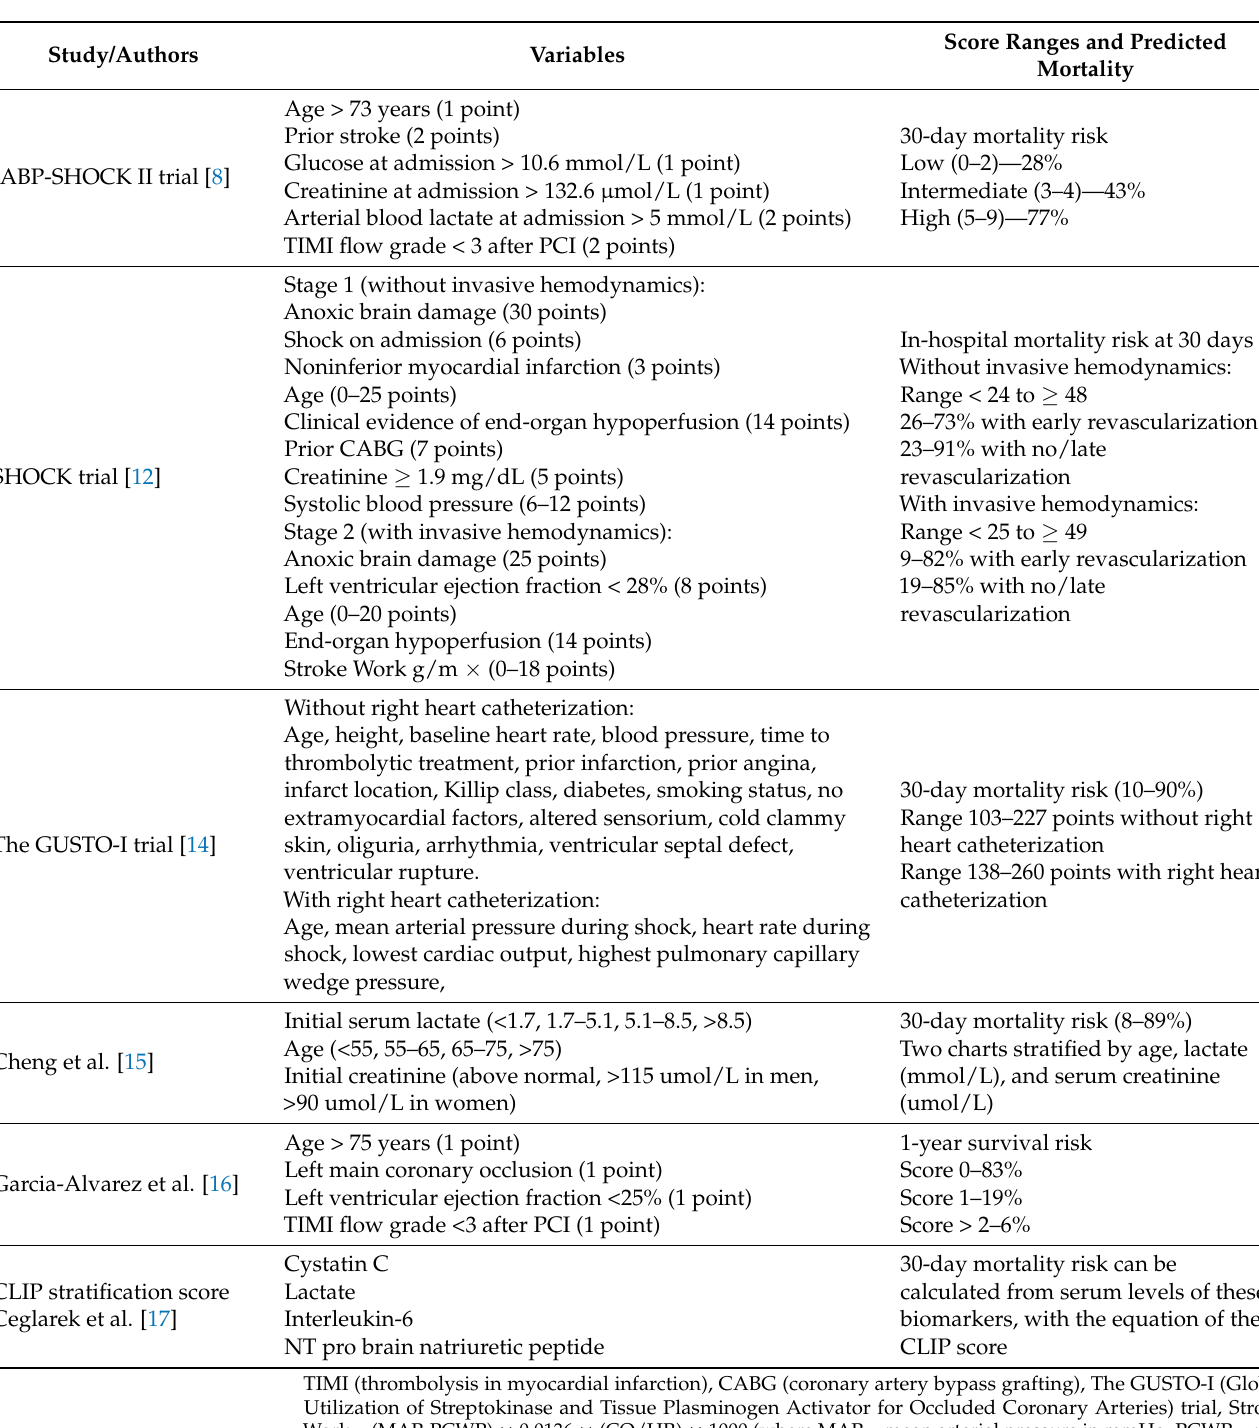
Table 1. Risk stratification score systems of cardiogenic shock